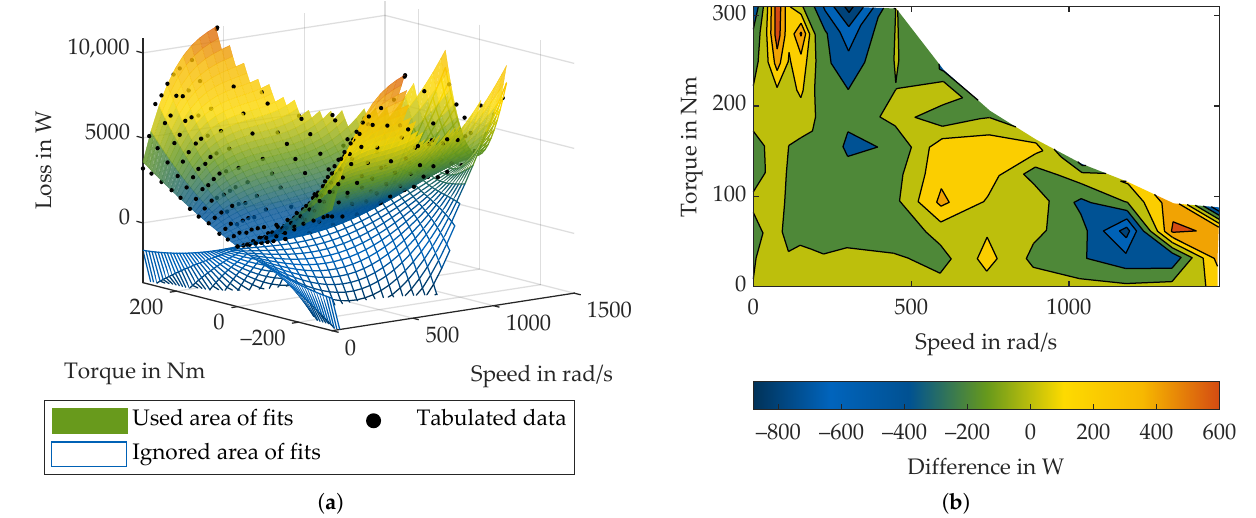
Figure 5. ( a ) Electrical motor losses of ID.3: fits of the split meta-model and the corresponding data points of the tabulated model. The ranges used due to the inequality constraints of Equations (36) and (37) are highlighted with the surface color. Irrelevant ranges of fits are presented with grid lines only. ( b ) Difference between fit and tabulated electrical motor losses.